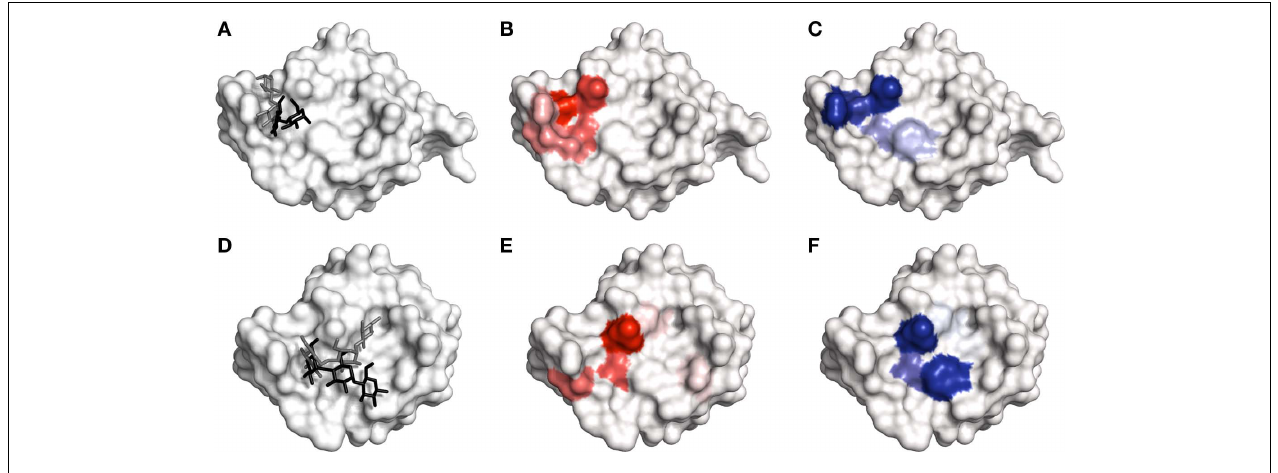
Glc α (1 → 4)Glc. (D) Comparison of crystal structure binding mode of Glc α (1 → 4)Glc α (1 → 4)Glc (PDB code 2GGU; black) with top ranked docked pose (gray). (E) Hydrogen bonding map obtained for the recognition of Glc α (1 → 4)Glc α (1 → 4)Glc. (F) van derWaals map obtained for the